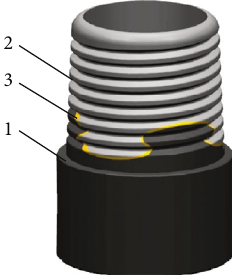
Figure 5: Schematic diagram of bionic structure of drill pipe joint.